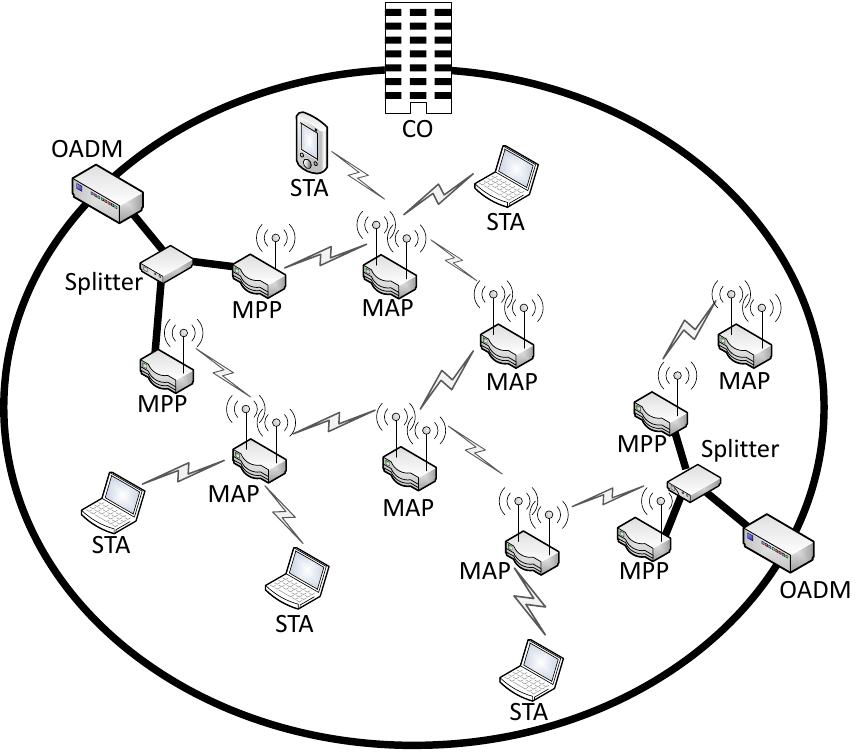
Figure 5. Unidirectional ring/PON architecture integrated with a WiFi-based WMN